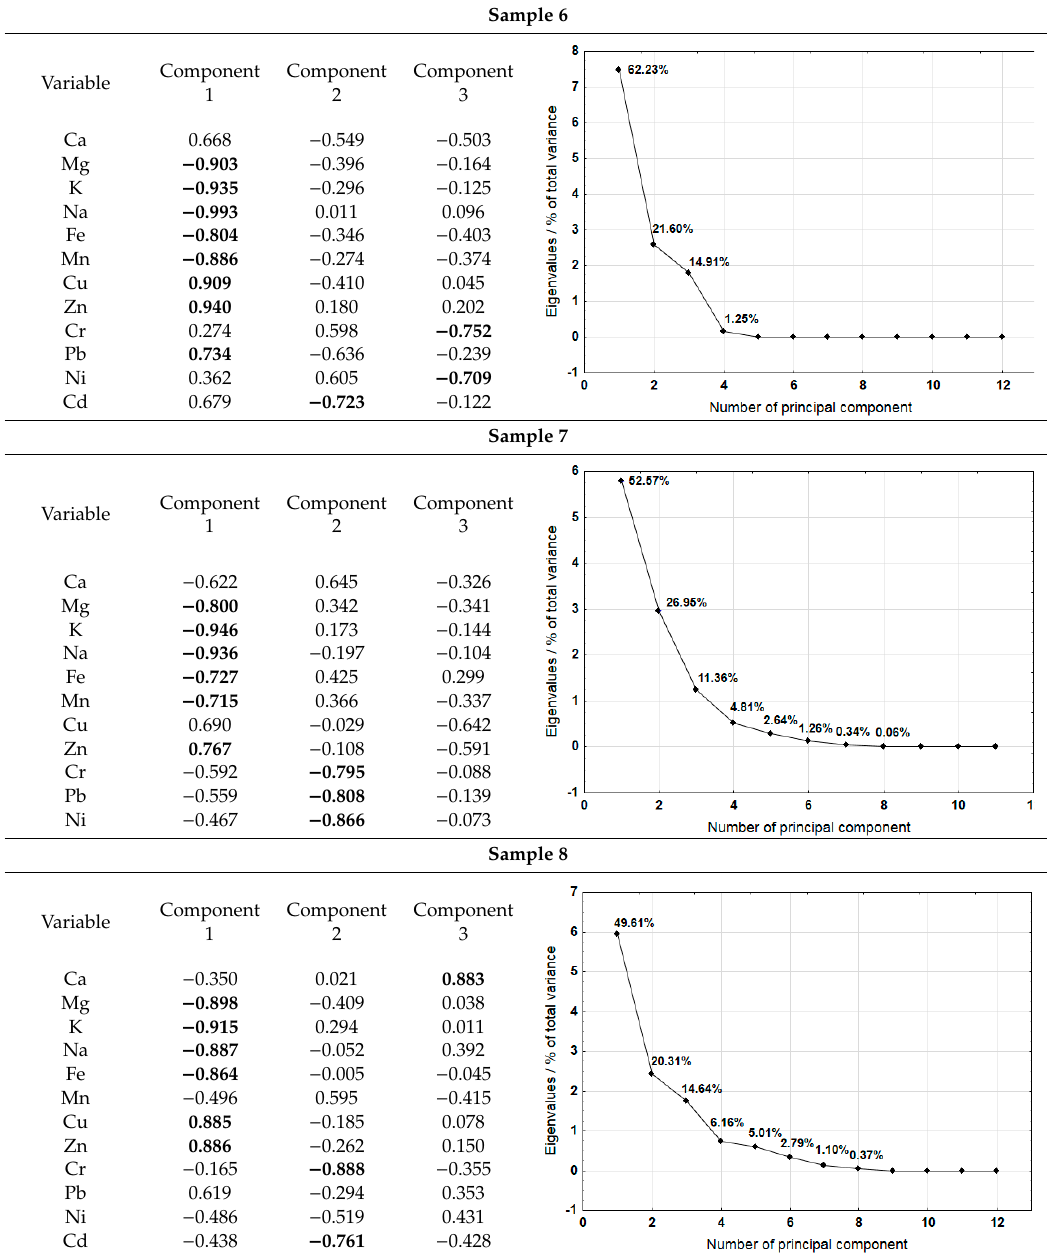
Table 9. The results of the Principal Component Analysis (PCA)for samples 9, 10, and 12 Sample